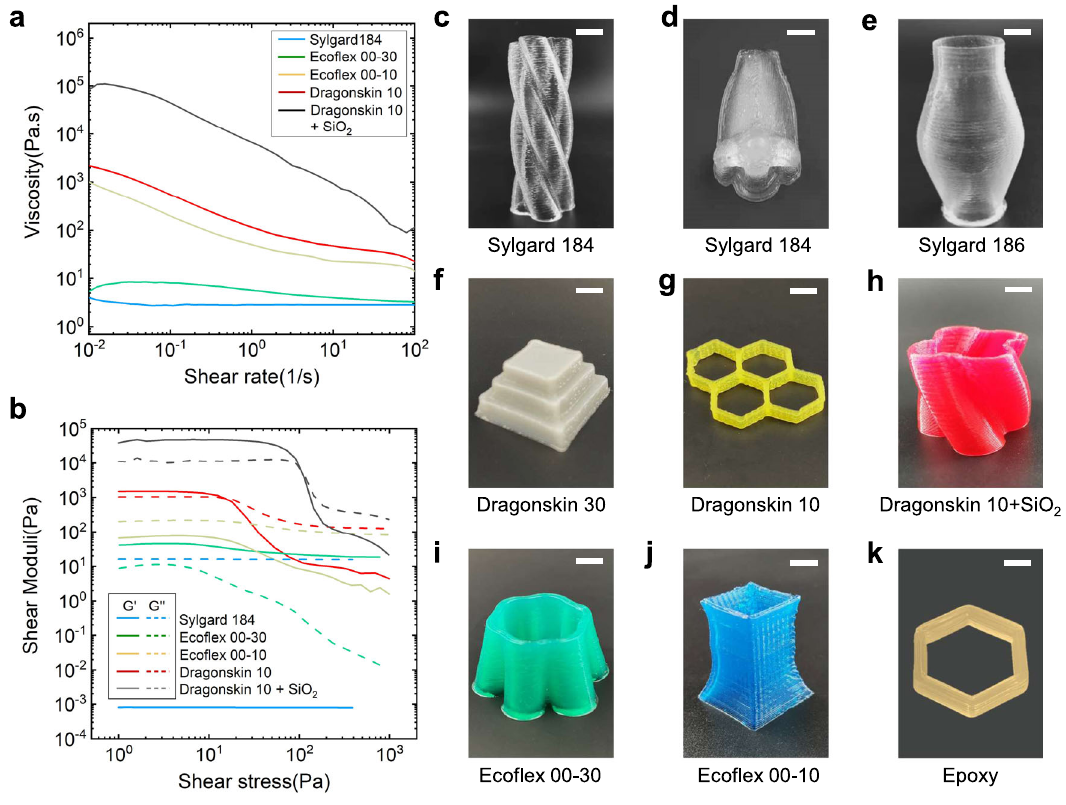
Fig. 4 | Demonstration of ISDH-enabled DIW of diverse thermosets. a , b Viscosity and shear moduli of some typical thermosetting inks with variable rheologicalproperties. c – k ISDH-printedpartsusing c , d Sylgard184; e Sylgard186;